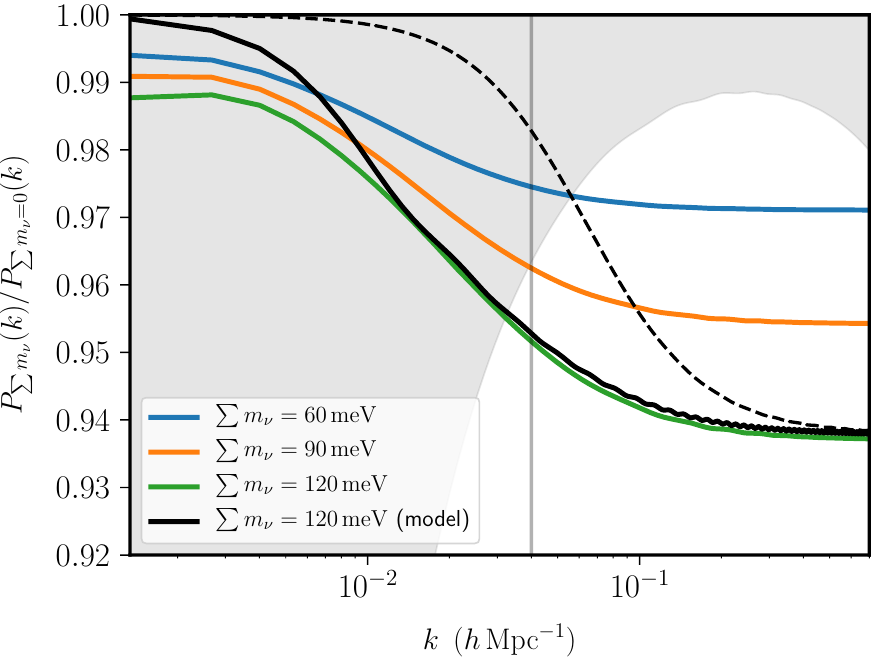
Figure 1 . Signal of neutrino mass in the matter power spectrum. The colored lines indicate the results from CLASS [55] when varying P m ν holding H 0 , Ω cdm h 2 , Ω b h 2 , and A s fixed. For comparison, the vertical line indicates the estimated free streaming scale from equation (3.10) and the solid (dashed) black line show the result of our numeric (analytic) solution to the fluid equations for P m ν = 120 meV, showing excellent agreement between the fluid approximation and the Boltzmann code. The grey band indicates the 1 σ noise associated with a BOSS-like galaxy survey [56] from the combination of cosmic variance and shot noise, which dominate at low and high k